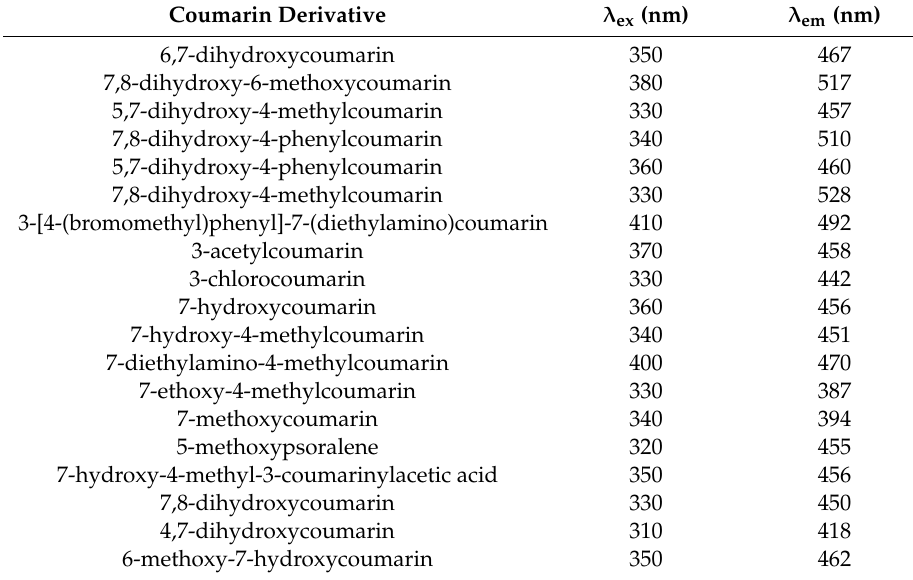
Table 2. Excitation and emission wavelengths of the studied